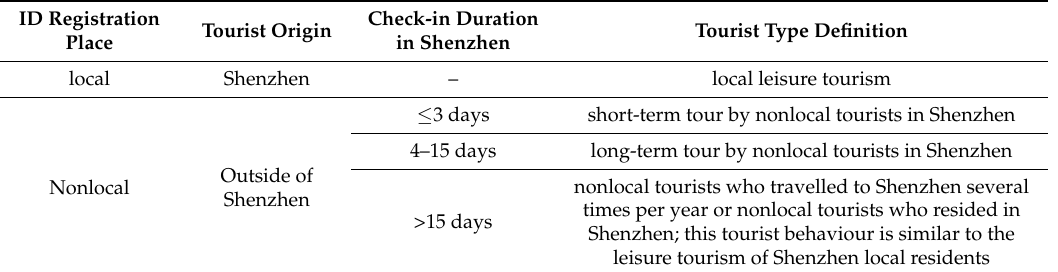
Table 1. Tourist source and formation based on ID creation place and check-in duration in